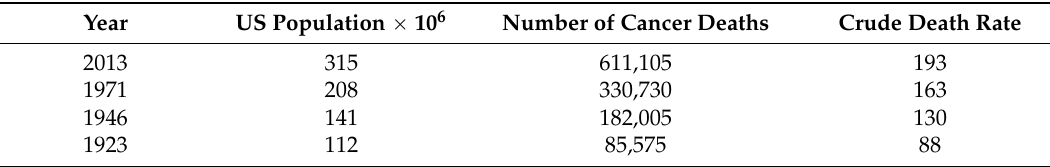
Table 1. Cancer deaths and death rates in U.S. 1923–2013